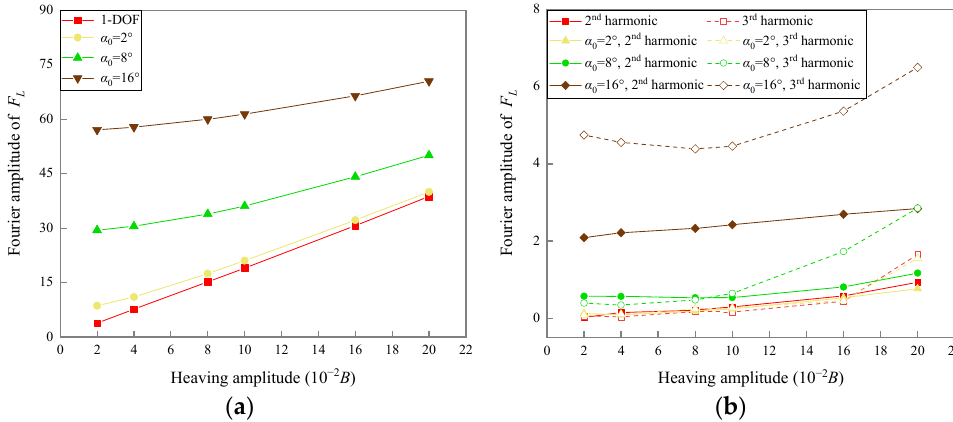
Figure 14. Variation in Fourier amplitude of aerodynamic lift with heaving amplitude. ( a ) The fundamental frequency ( b ) Second harmonic and third harmonic.